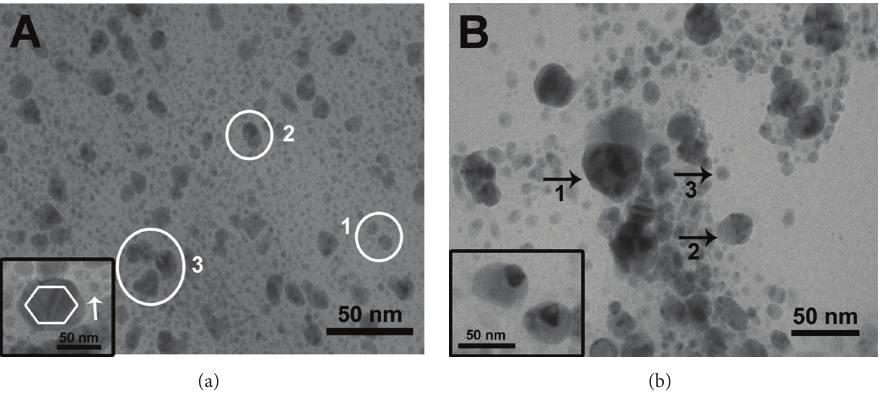
Figure 7: TEM images of silver nanoparticles synthesized by using leaf (a) and stem extract (b) of Piper nigrum.